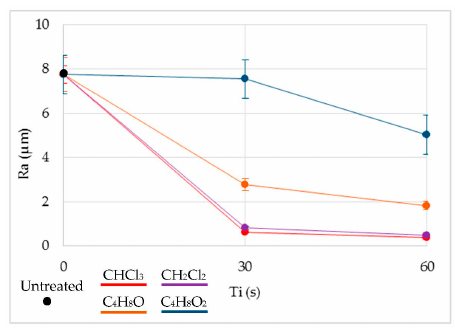
Figure 4. R a as a function of immersion times (Ti) and the different solvents.